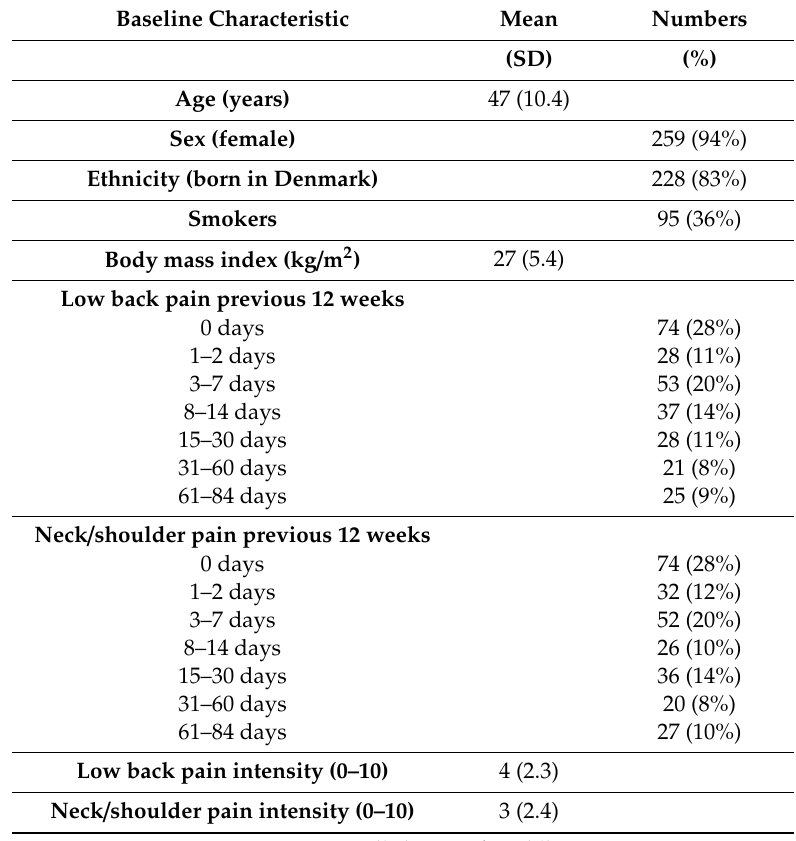
Table 1. Baseline characteristics of 275 eldercare workers in 20 nursing homes in Denmark. Baseline Characteristic